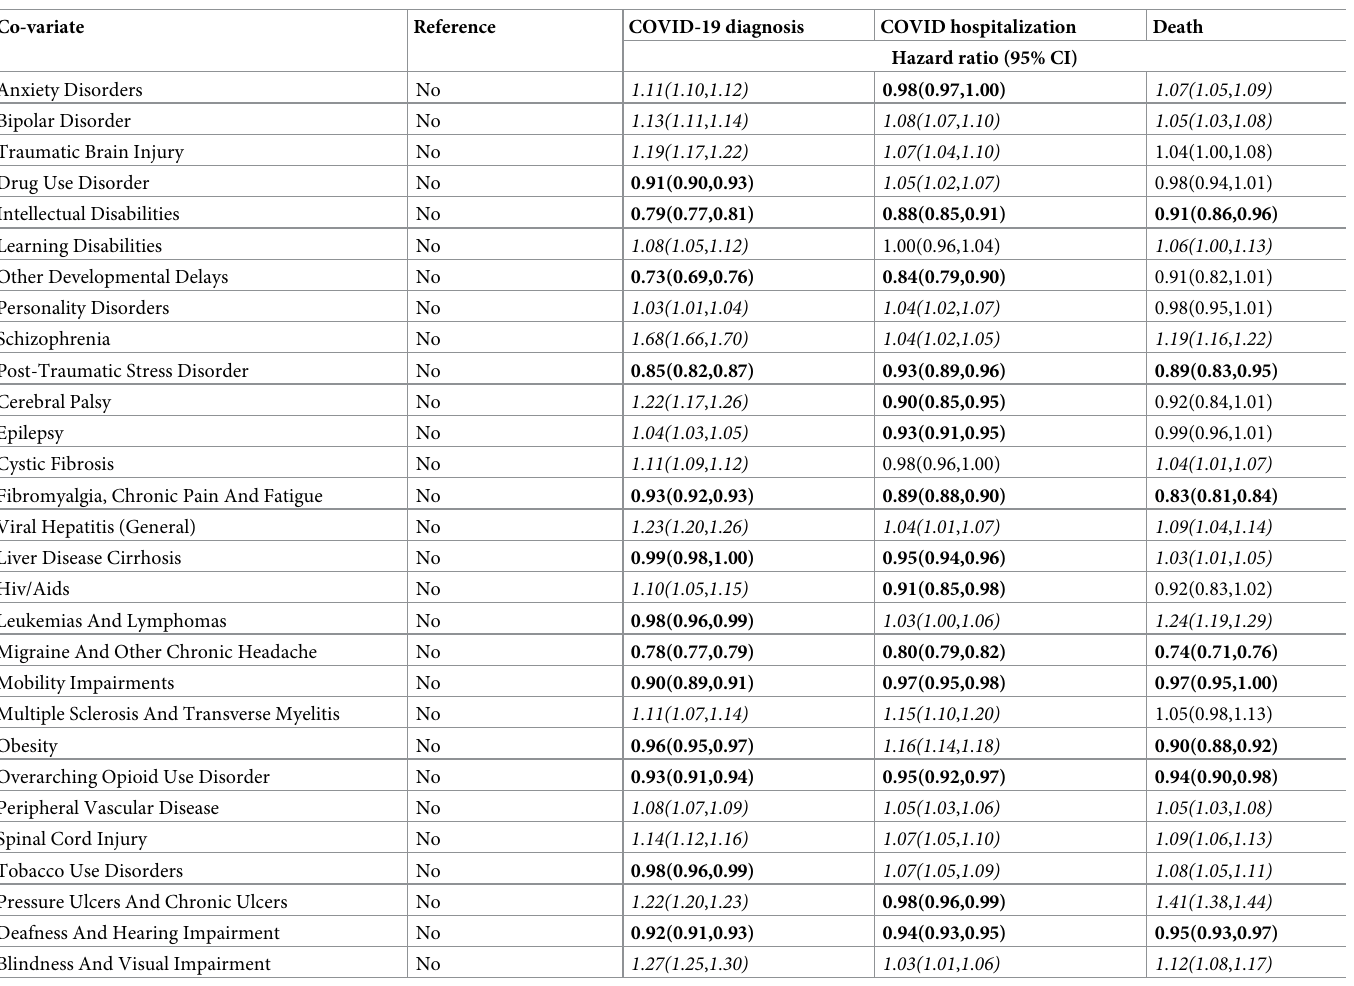
never users (Table 3). Hydroxychloroquine did not show any effect when recent starters were censored. The risk of COVID-19 hospitalization increased monotonically with age (Table 4). Compared to the 65–69 age group, the risk increased by 10%, 40%, 63% and 95% for groups 70–74, 75–79, 80–84 and � 85 respectively. Female sex was associated with a 20% reduced risk compared to male. The risk of COVID-19 hospitalization for Hispanics was 19% higher than whites. Poorer patients were associated with higher risks of hospitalization with COVID-19. The three co-morbidities associated with largest increase in risk were hypertension (134%), chronic kidney disease (34%) and dementia (32%).